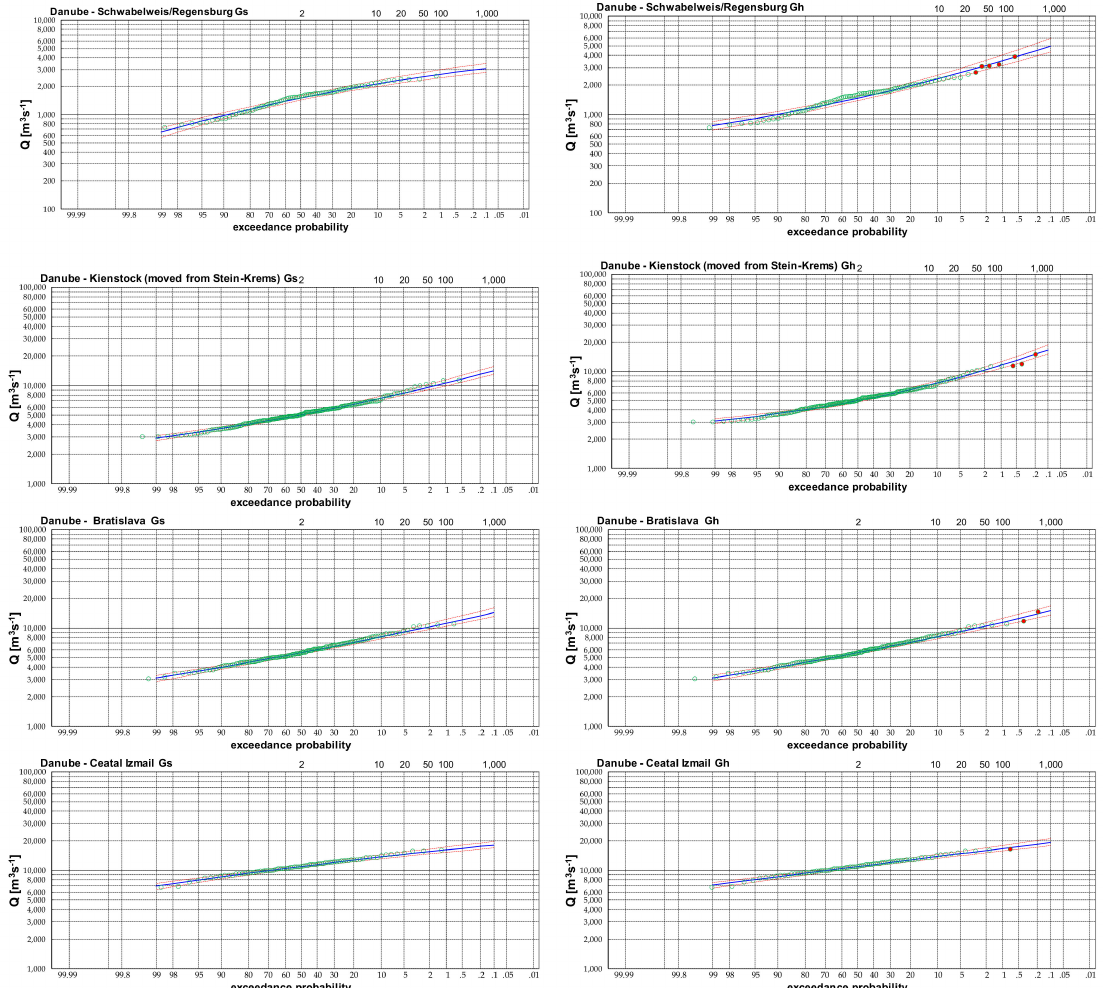
Figure 4. Examples of the theoretical LPIII exceedance probability curves of the Danube maximum annual discharges without historical data ( left ) and with historical data (red points, right